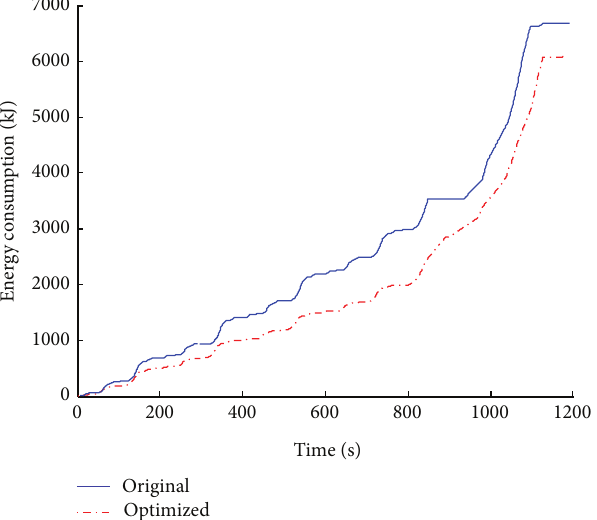
parameters such as acceleration, gradeability, the maximum speed, and driving range of the electric cars equipped with the dual-motor hybrid drive system met the design requirement, had high performance, and saved